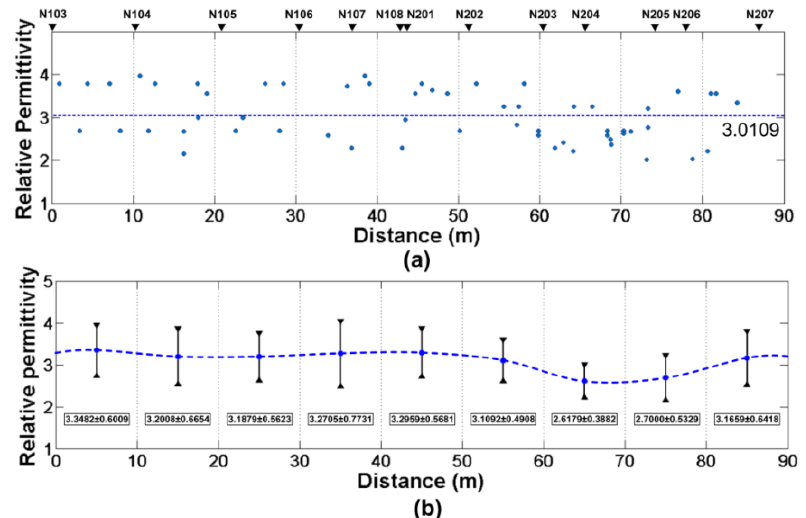
Figure 17. Analysis between permittivity and the location. ( a ) Scatterplot of permittivity and distance. ( b ) The average estimated dielectric constant of regolith at each 10 m. The error bars show the standard deviation.